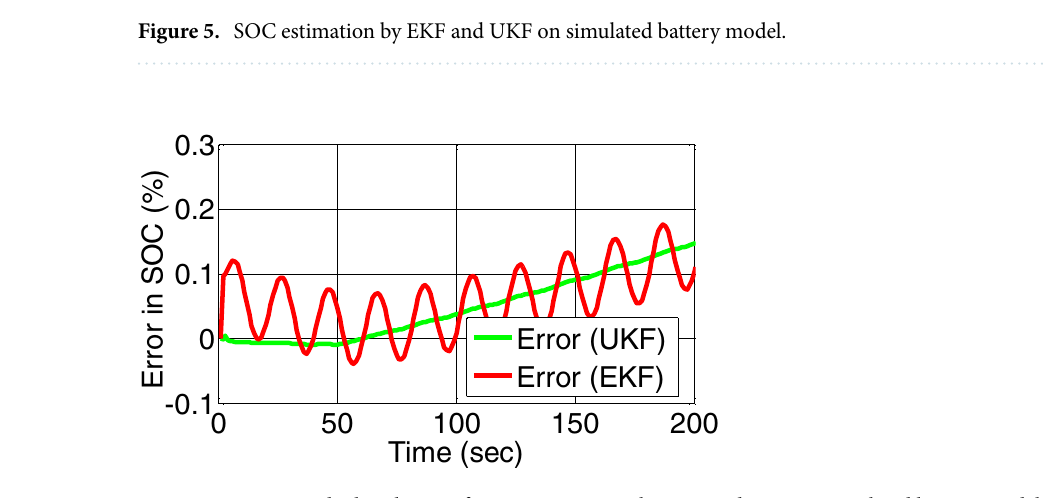
Figure 6. Error/residual evaluation for SOC estimation by EKF and UKF on simulated battery